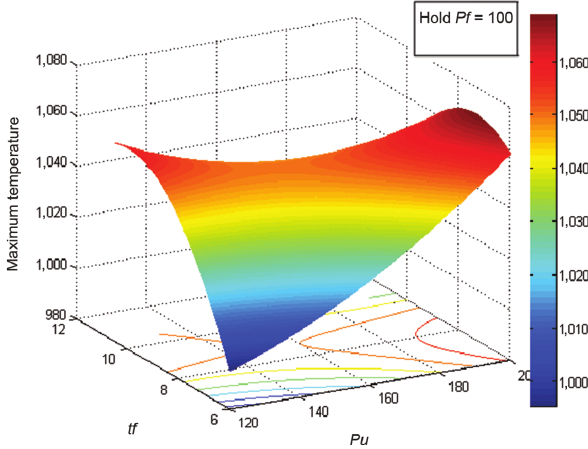
Figure 11: Surface plot of maximum temperature versus tf and Pu .